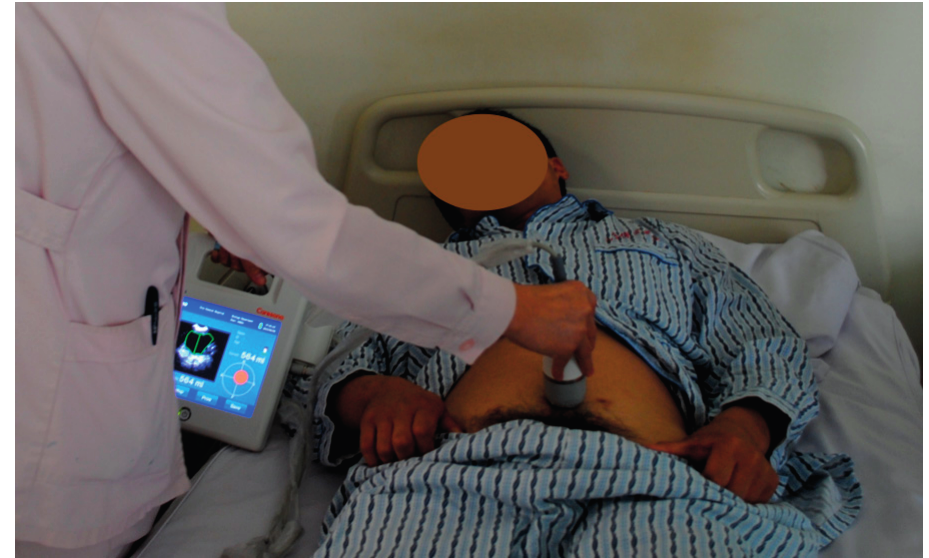
Figure 7. Chinese bladder volume scanner based on US findings to check bladder